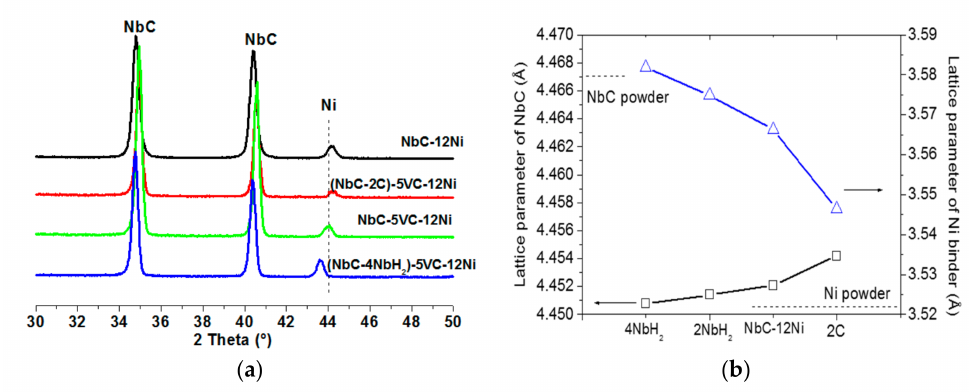
Figure 6. Influence of C content on the XRD phase patterns ( a ) and lattice parameter ( b ) of NbC and Ni binder phases in the 5 vol % VC modified NbC-12 vol % Ni cermets.